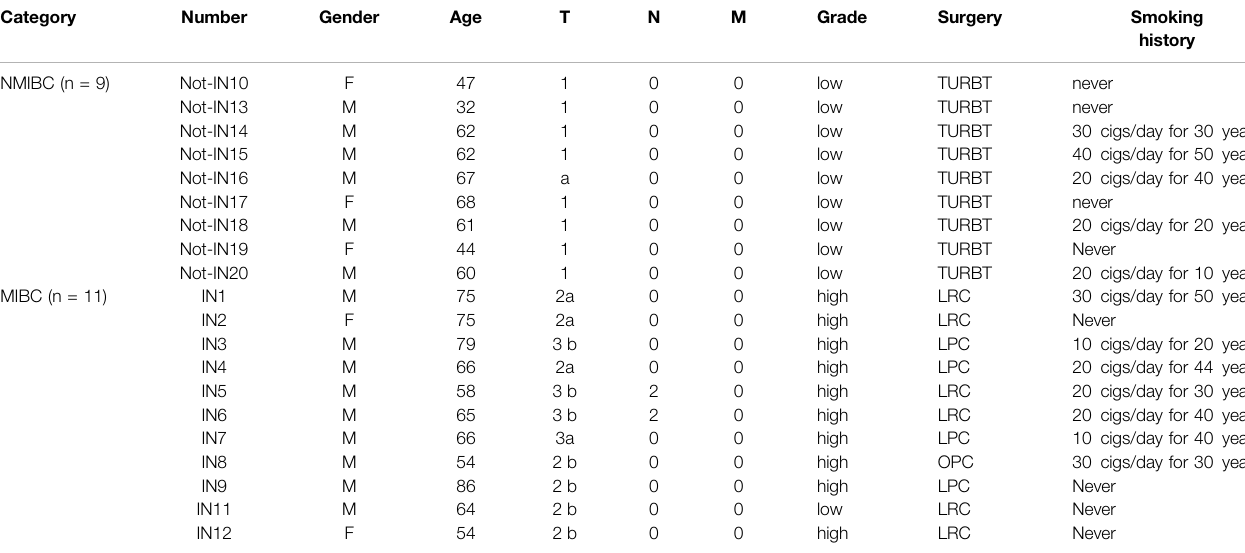
NMIBC:non-muscleinvasivebladdercancer;MIBC:muscleinvasivebladdercancer;F: female; M:male; TURBT:transurethralresectionofthe bladdertumor; LRC:laparoscopicradical cystectomy; LPC: laparoscopic partial cystectomy; OPC: open partial